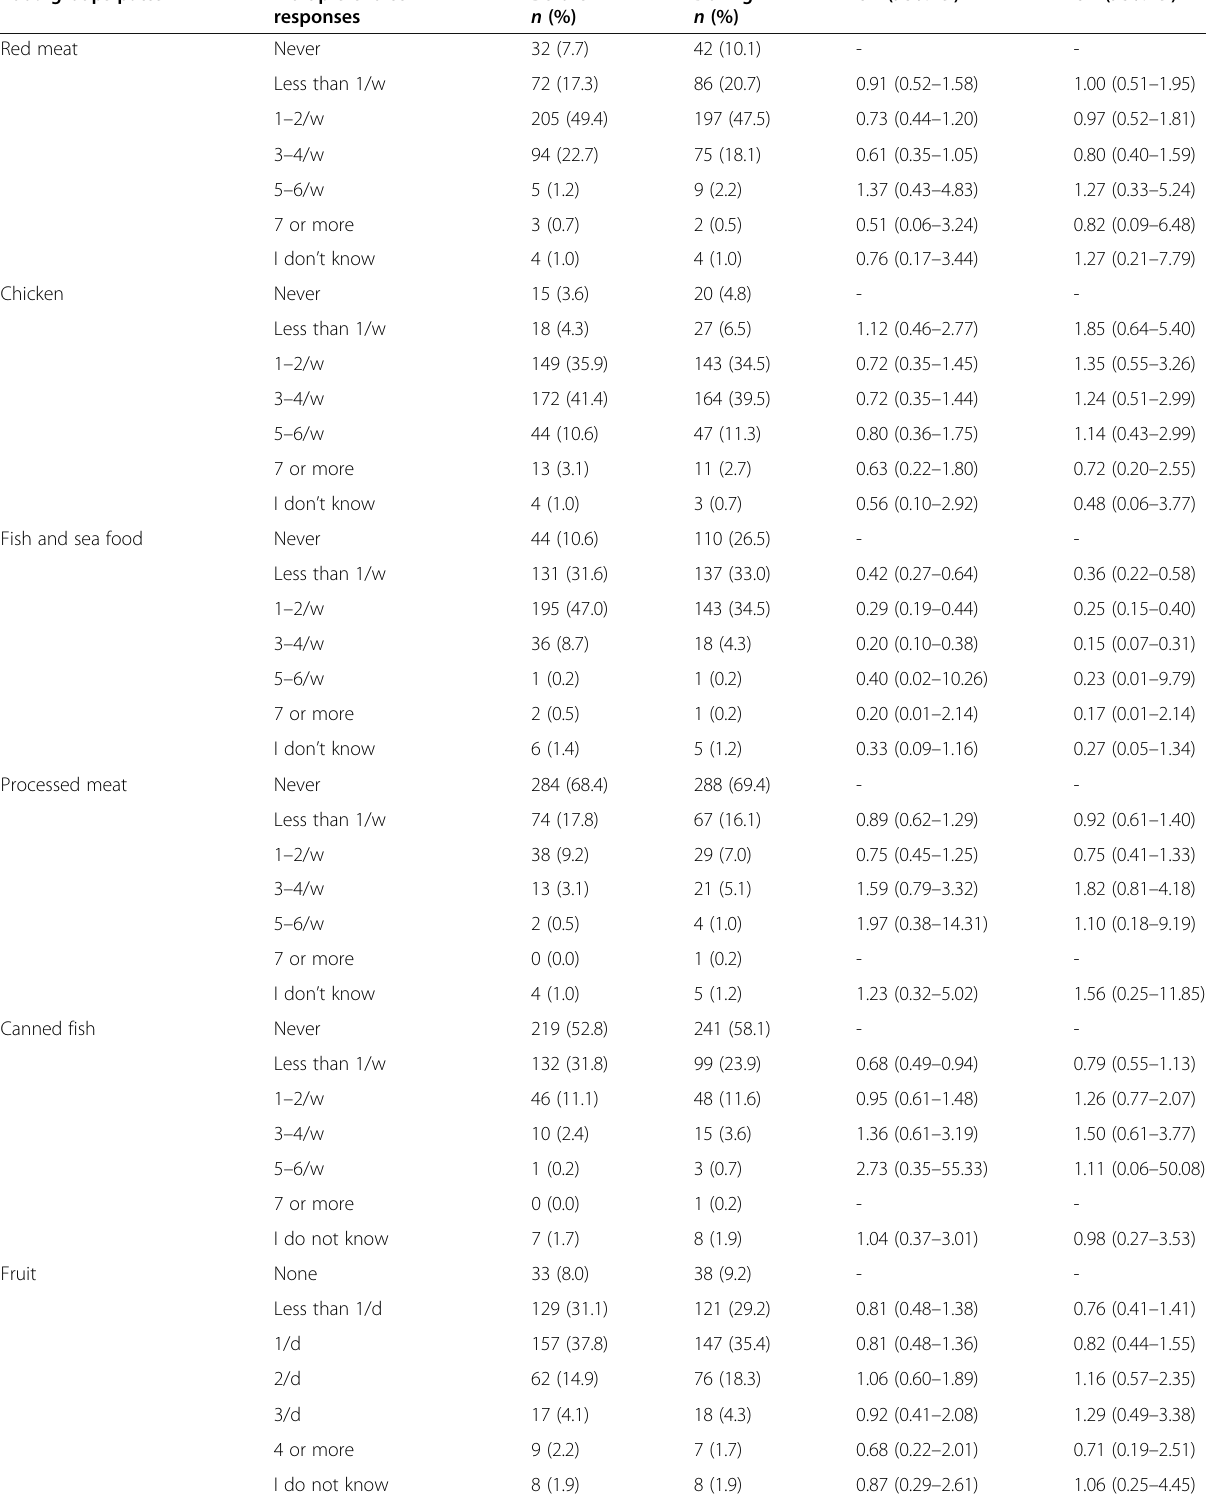
Table 3 Multivariate analysis between two periods using logistic regression for food groups pattern Food groups